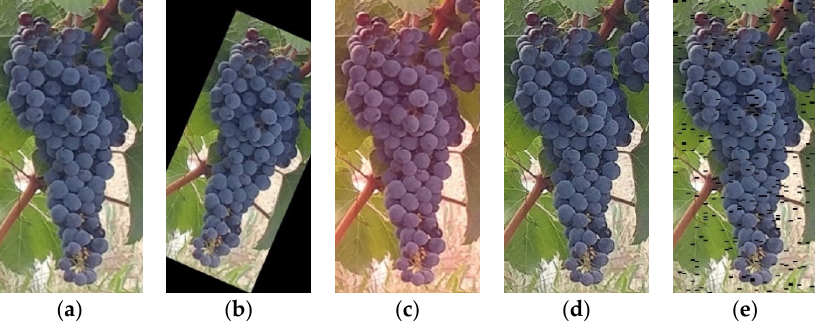
Figure 2. Illustrations of the dataset augmentation: ( a ) original image; ( b ) rotation; ( c ) channel enhancement; ( d ) Gaussian blur/noise; and ( e ) rectangle pixel discard.